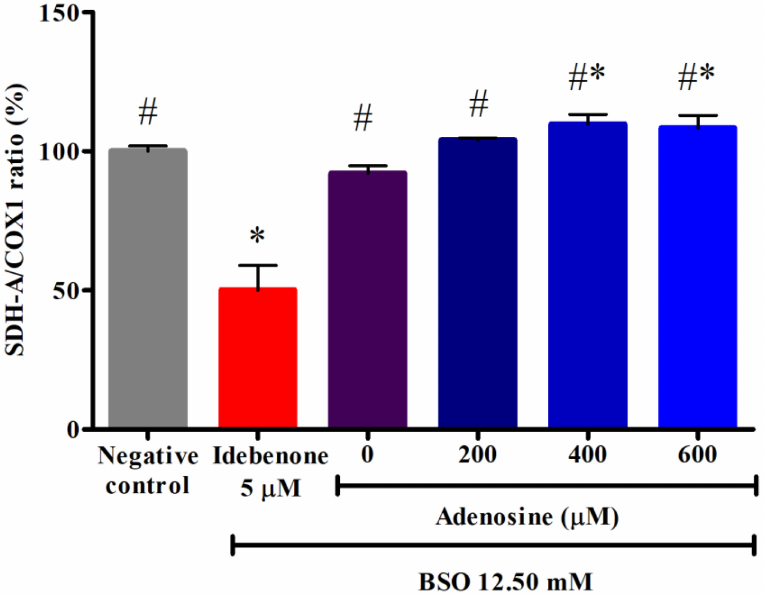
Figure 5. Effects of adenosine on the mitochondrial biogenesis in FRDA fibroblasts treated with BSO. Mitochondrial biogenesis was evaluated following pre-treatment with adenosine for 2 h and 12.50 mM BSO for 24 h. Data are expressed as mean ± SD and statistically analyzed by one-way ANOVA with Tukey’s post-hoc test. Hash (#) and asterisk (*) indicate significant differences ( p < 0.05) in the SDH-A/COX1 ratio compared to the idebenone group and BSO-treated (0 µ M adenosine) group, respectively. BSO, L-buthionine sulfoximine; COX1, cytochrome c oxidase subunit 1; SDH-A, succinate dehydrogenase subunit